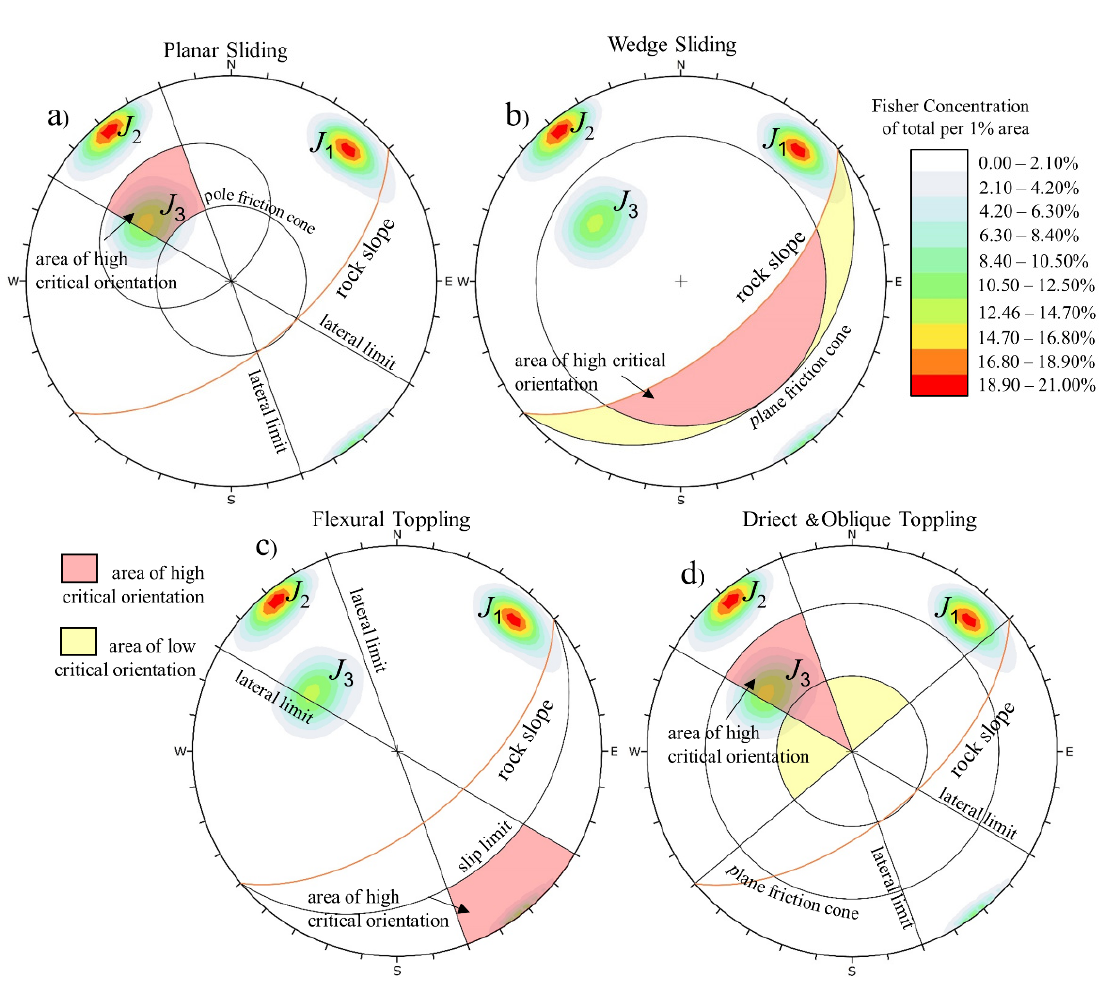
Figure 10. Kinematic analysis using the poles of discontinuous orientations measured in SfM point clouds of dangerous rock mass (lower-hemisphere and equal-area projection). ( a ) Planar failure; ( b ) wedge failure; ( c ) flexural toppling; ( d ) direct toppling.